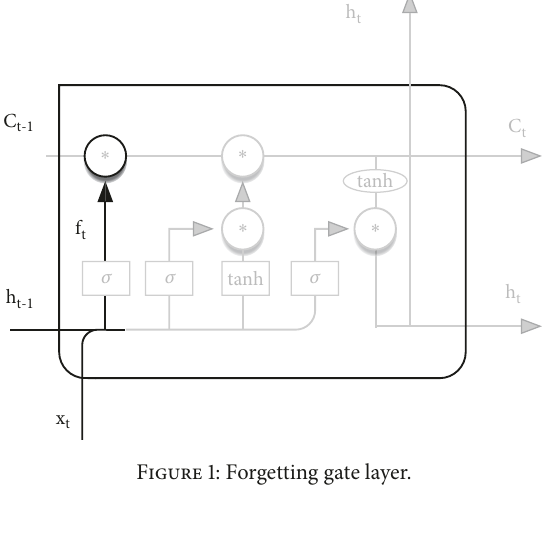
Figure 1: Forgetting gate layer.